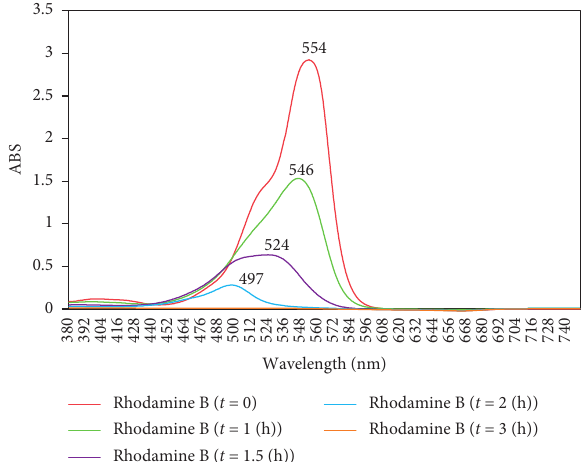
Figure 9: Effect of catalyst concentration on the RhB degradation efficiency of C, N-TiO 2 .